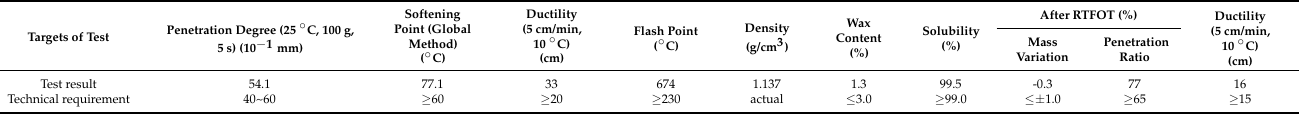
Table 1. Main technical indexes of SBS-modified